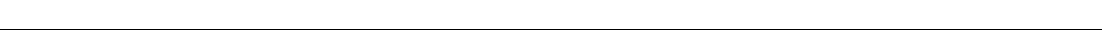
Fig. 2 Chemogenetic activation of the mesoaccumbens, but not mesocortical, pathway mimicked the effects of cocaine and D-amphetamine on reversal learning. a Experimental design. b (Left panel) Representative histology images showing coronal sections stained for tyrosine hydroxylase (left), DREADD- mCherry (middle), and an overlay (right). Scale bar, 500 μ m. (Right panel) Co-staining of mCherry with tyrosine hydroxylase, showing the percentage of DREADD-transfected neurons that is dopaminergic (mean ± s.d.). Data from n = 9 (mesoaccumbens), n = 8 (mesocortical) animals. c – f